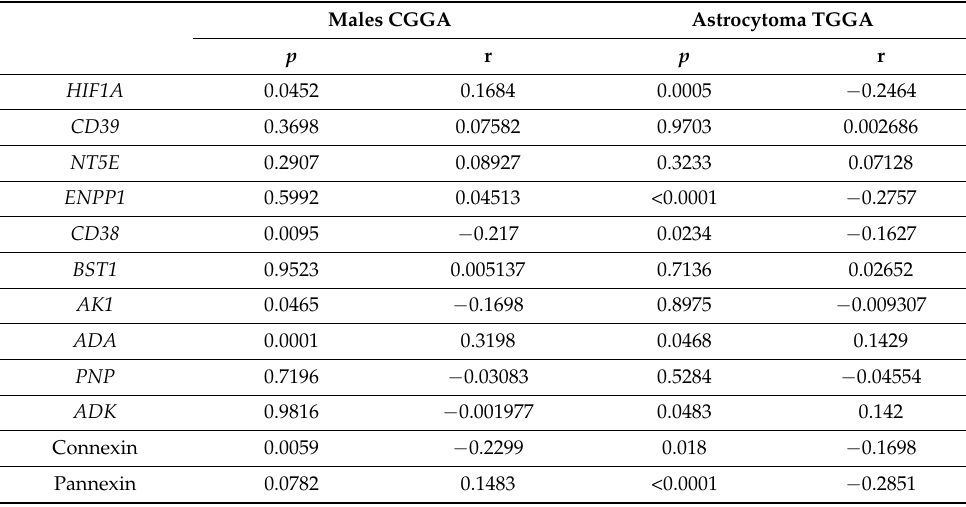
Figure 10. Identification of genes that were uniquely overexpressed in the CCGA males compared with the TCGA astrocytoma group according to A 2A R expression. ( a ) Volcano plot showing genes differentially expressed according to A 2A R expression in CGGA male patients (right of volcano) (fold change ≥ 0.5; p value ≤ 0.05). ( b ) Volcano plot showing genes differentially expressed according to A 2A R expression in TGGA astrocytoma patients (right of volcano) (fold change ≥ 0.5; p value ≤ 0.05); ( c ) Venn diagram showing genes not in common between the two groups. Table 7. Principal pathways overexpressed in CGGA males compared with the TCGA astrocyto- ma group in correlation with the A 2A R expression obtained through INOH enrichment. Table 8. Association of A 2A R expression with genes related to adenosine production and metabolism, in CGGA males and TCGA astrocytoma, suggesting elevated extracellular adenosine levels in CGGA